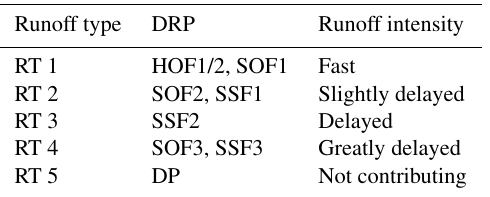
Table 2. Reclassification of DRPs in runoff types accord- ing to their contribution to runoff (HOF = Hortonian Overland Flow; SOF = Saturation Overland Flow; SSF = Subsurface Flow; DP = Deep percolation). 1 represents an almost immediate reaction, 2 a slightly delayed one, and 3 a greatly delayed one. Adapted from Naef et al.